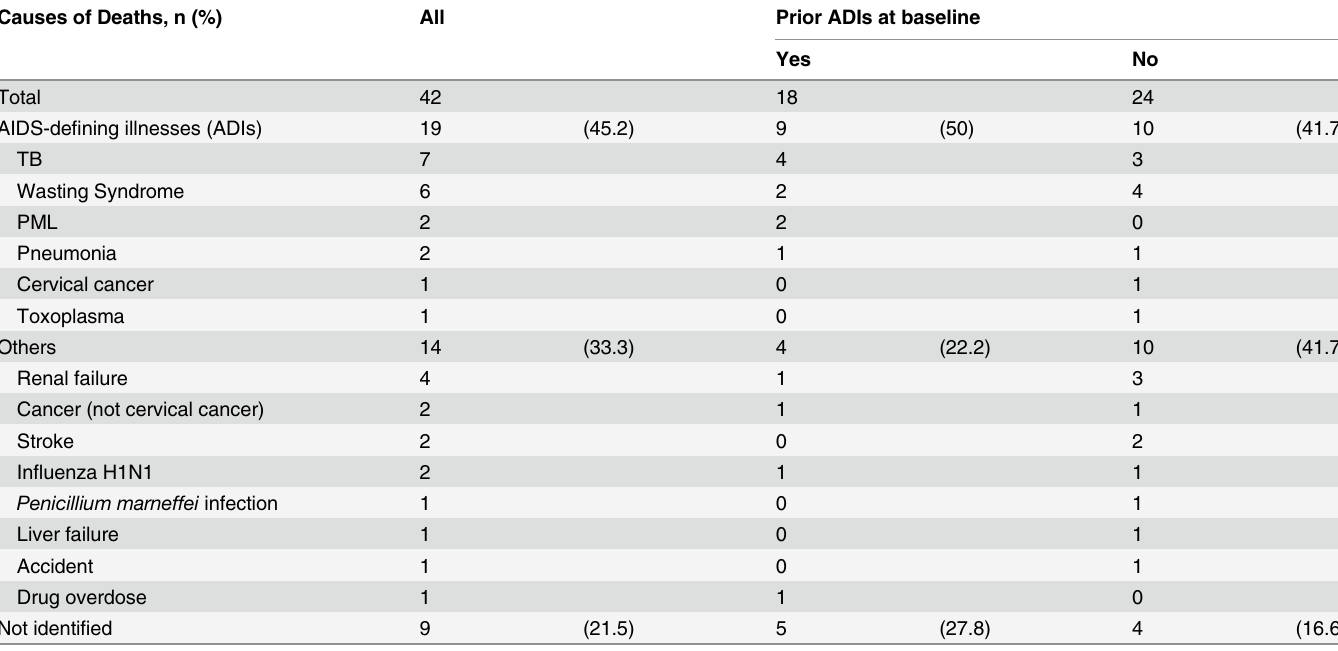
Table 4. Causes of